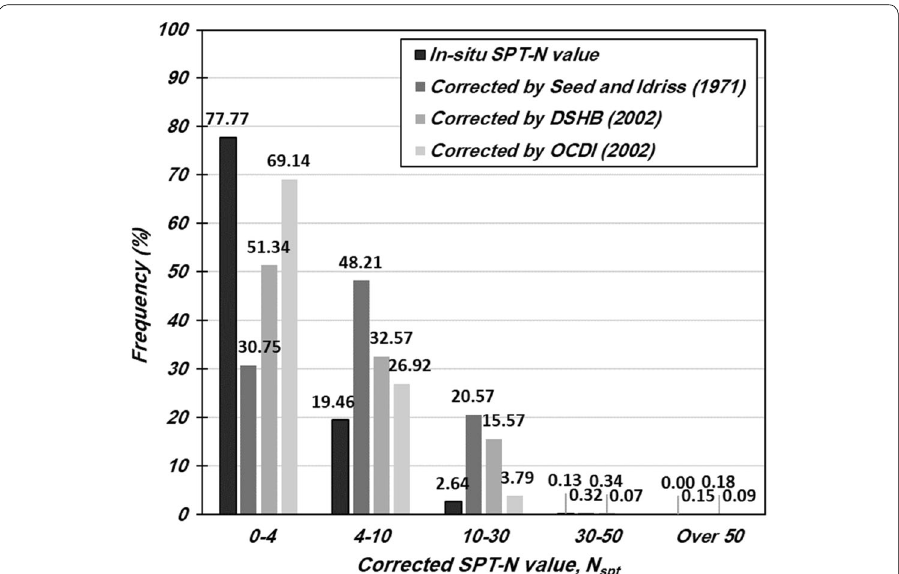
Fig. 12 Histogram of corrected SPT N‑values by three methods